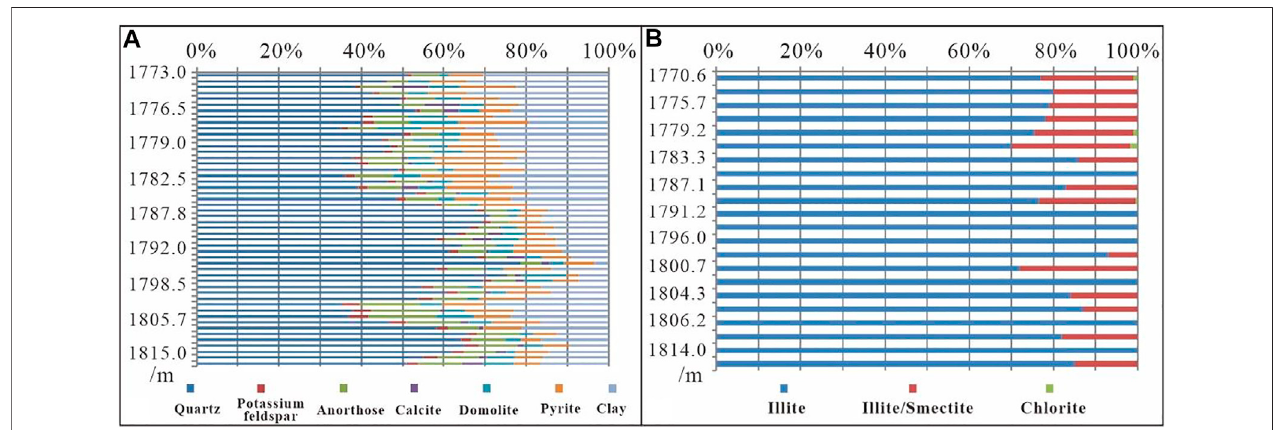
FIGURE 2 | Mineral composition and content of Niutitang shale (A) and clay minerals (B) in TX-1 well.